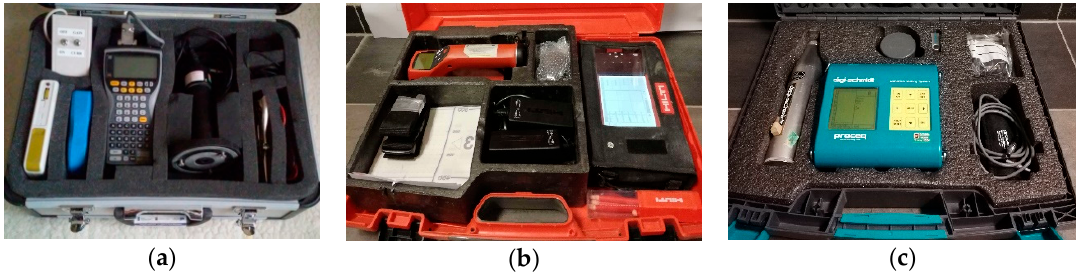
Figure 2. Measuring devices: ( a ) GP-5000 GalvaPulse TM kit, ( b ) Ferroscan PS200, and ( c )